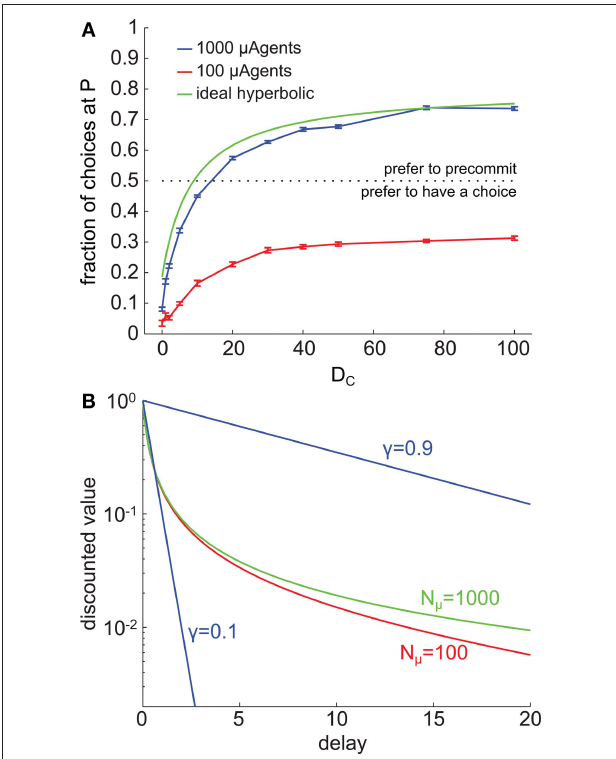
Figure 8 | Precommitment is highly dependent on the shape of the discount curve. ( A) These graphs plot the average (across 200 trials) number of times each choice was selected at different values of D . The blue line C shows choices made when N = 1000, and the red line shows choices made μ when N = 100. (B) The shape of the average discount function depends on μ the number of μAgents. Red shows the average discounting of 100 μAgents and green shows the average discounting of 1000 μAgents. If a perfect hyperbolic function is plotted on this graph, it overlies the green curve. For reference, exponential discount curves with γ = 0.1 and γ = 0.9 are plotted in blue. The vertical axis is log scale to make visible the separation of the red and green curves. In this figure, k =